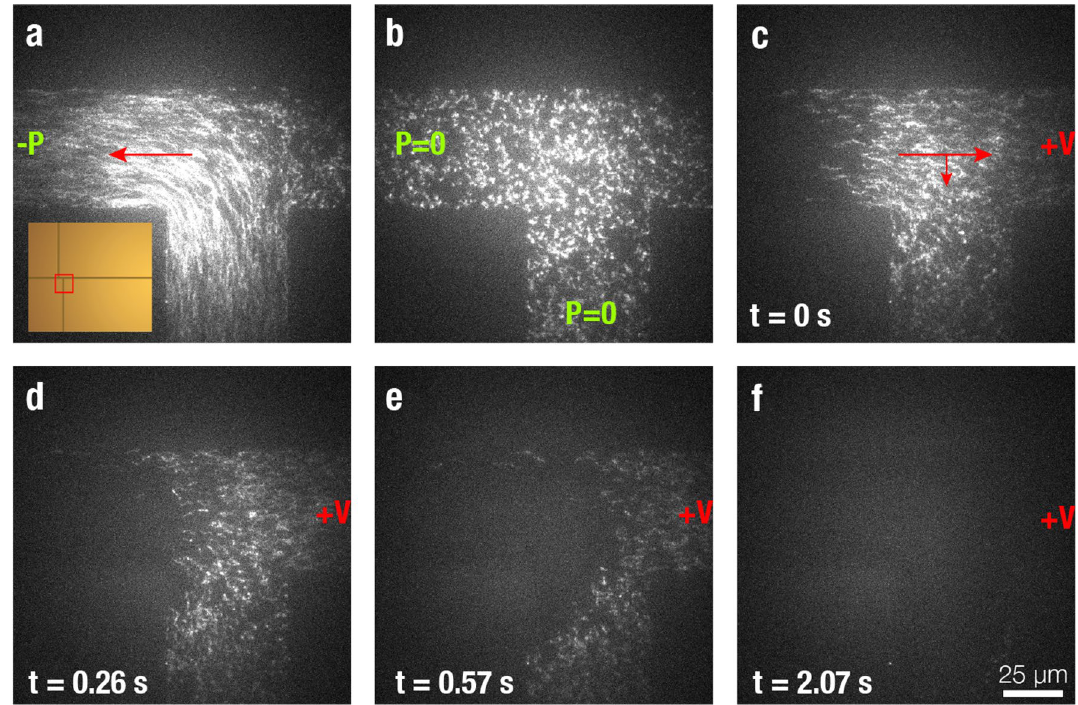
Figure 2. Protein loading in channel. ( a ) The vacuum is turned on, pulling samples from the loading reservoir into the T-junction. Inlet shows the position on the chip. ( b ) The vacuum is turned off, and individual Atto647N-BSA appear distorted due to Brownian motion. ( c ) Subsequently, the voltage (30 V) is turned on, and the proteins are driven in the direction of the electric field. ( d ) The protein plug divides between the separation channel and loading channel, and ( e ) proteins in the loading channel return to the loading chamber. As the electric field is stronger in the separation channel, most proteins present there are driven to the polyacrylamide gel. Similarly, the electric field in the loading channel is biased towards the loading port, preventing protein leakage during separation. ( f ) The proteins disappear from the Figure 3 and Supplementary Video S2 show the protein stacking at the gel interface in real-time for an experi- ment with Atto647N-labeled BSA proteins at an applied 60 V/cm potential difference. At t = 2.14 s, the proteins begin to arrive at the gel interface, and their electrophoretic migration slows down due to increased resistance to movement. In the gel, Brownian motion is strongly dampened, and individual proteins are clearly identifi- able. Over the next ~ 1.5 s, all the proteins enter the gel and accumulate into a narrow band ~ 8 µm in thickness, as measured by a Gaussian fitting, performed for each frame (Fig. 3b). The four fittings for each frame capture the principle of protein stacking, as the half-width of the distribution narrows to a minimum as the mean posi- tion of the proteins increases. Once attaining this minimum (i.e., a stacked configuration), the protein plug will subsequently expand along the length of the gel as slight differences in protein labeling efficiency result in dif- ferent migration speeds. Another example using a higher concentration gel is given in Supplementary Fig. S3, demonstrating slower stacking.